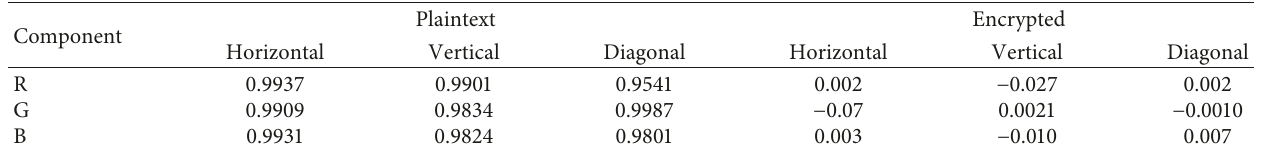
Table 5: The correlation coefficient analysis.